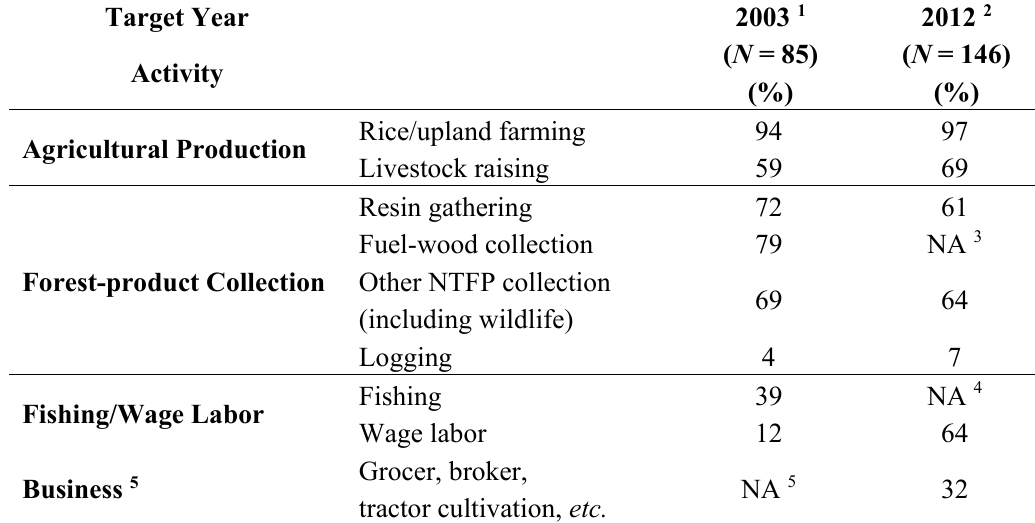
Table 1. Proportion of households (HHs) engaged in each activity in 2003 and 2012 subdivided into three